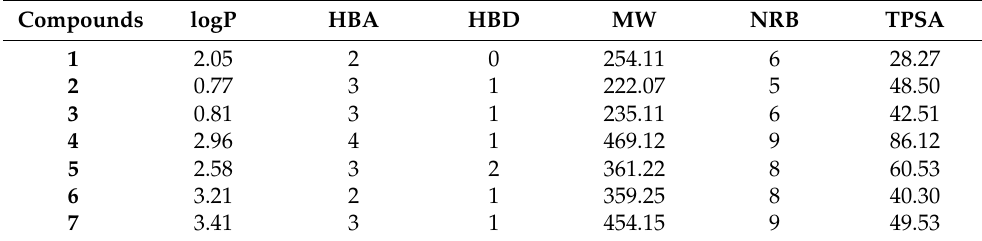
Table 3. Selected pharmacokinetic parameters of compounds 1 – 7 calculated with the SwissADME tool [http://www.swissadme.ch/, accessed on 15 February 2022].